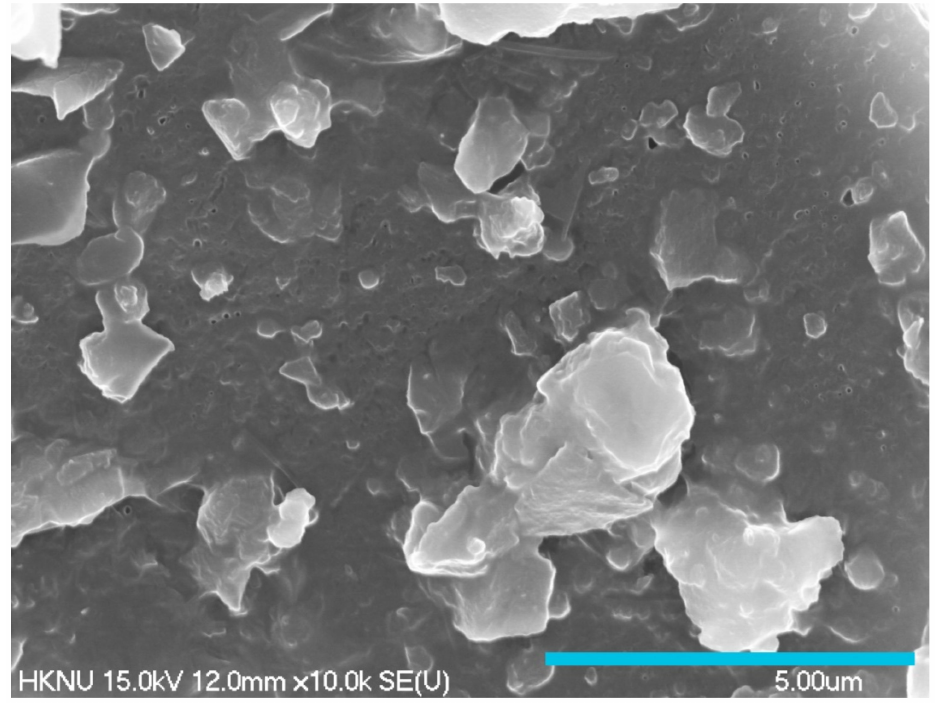
Figure 2. Surface morphologies of Al-FWB analyzed using a field emission scanning electron micro- scope (FE-SEM) under the conditions of accelerating voltage of 15.0 kV, magnification of × 10,000, and scale bar and 5.00 µ